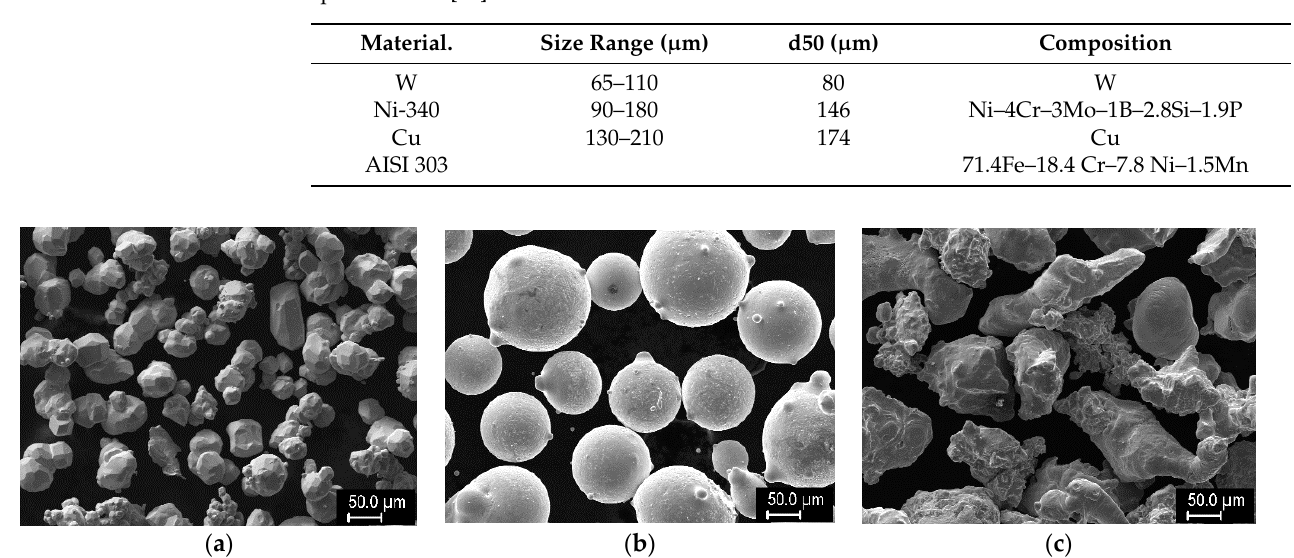
Table 1. Characteristics of the used materials. For the steel substrate, the presented composition comes from X-ray fluorescence spectrometry (XRF) measurements and agrees well with the general specifications [25].